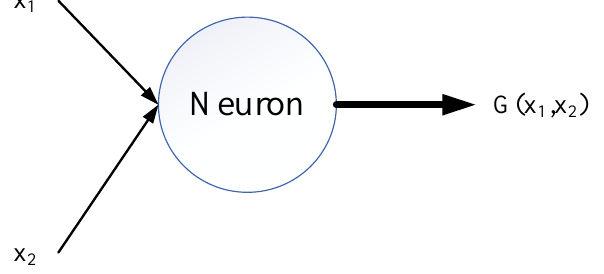
Figure 4. A neuron of the GMDH networks.